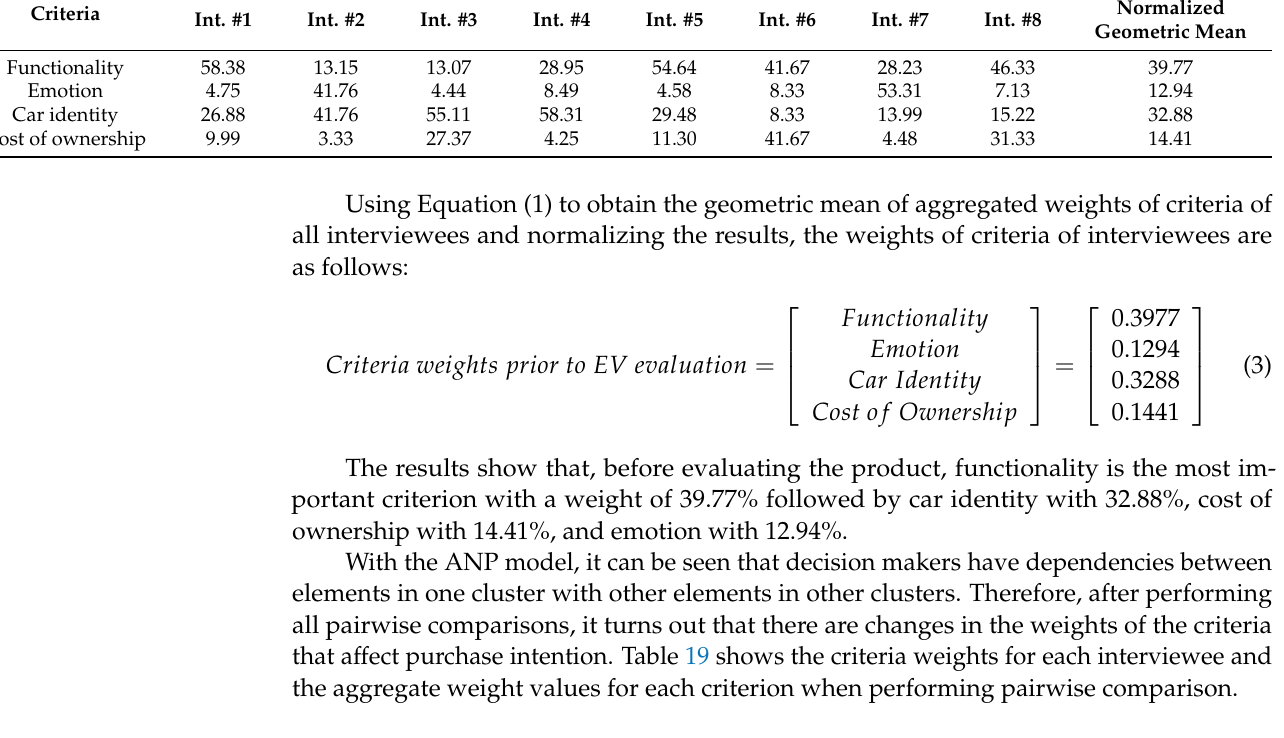
Table 19. Interviewees’ criteria weights during EV